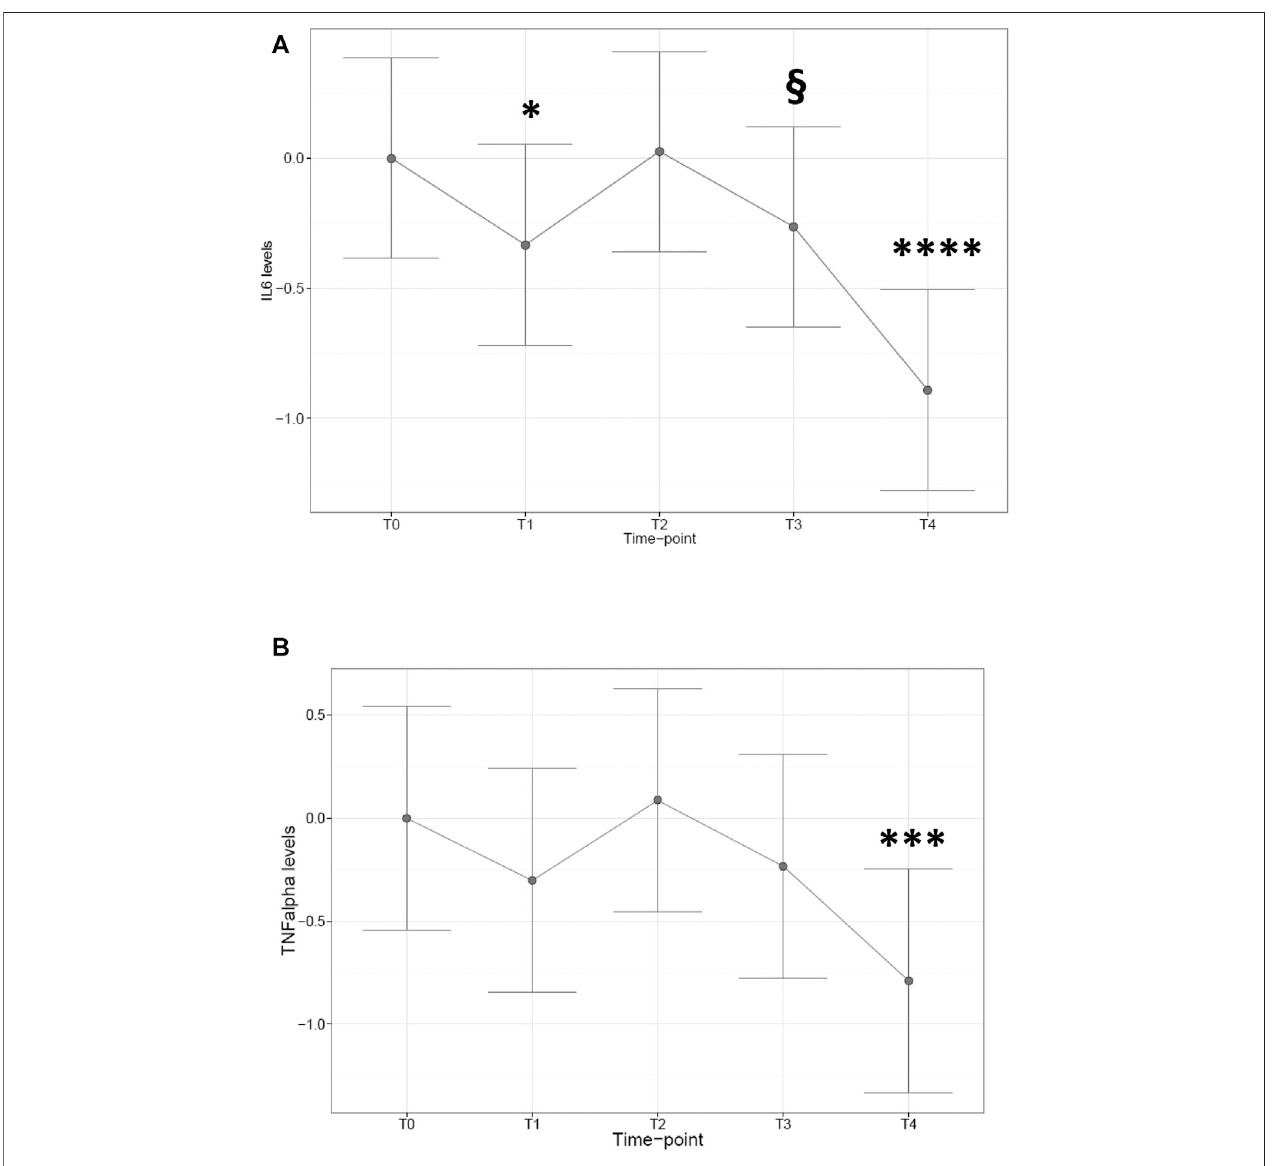
FIGURE 3 | Cytokine mRNA expression in patients at different time-points. Plot of the least square predicted means with 95% con fi dence intervals. The predicted least square means werecalculated using a 1-way repeated measures mixed model. (A) : IL6; (B) : TNF α . Ordinate axis is displayed on the Log10 scale. * p < 0.05; *** p < 0.001; **** p < 0.0001; § 0.05 < p < 0.1 in planned comparisons with T0 levels. n (cid:2) 11 patients repeatedly assessed at 5 time-points.